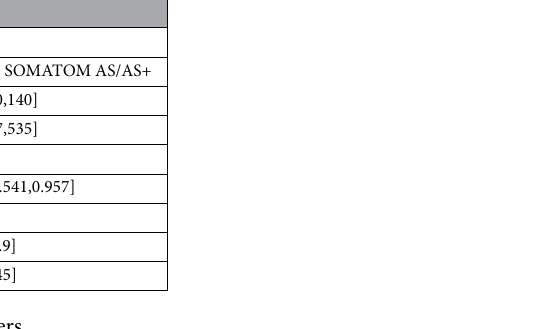
Table 1. CT image acquisition